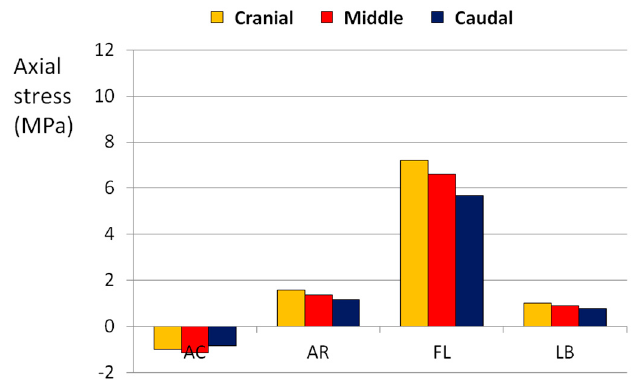
Figure 9. Axial stress generated in the POST section by pure loads. AC means axial compression, FL means flexion, AR means axial torsionrotation, LB means lateral bending.